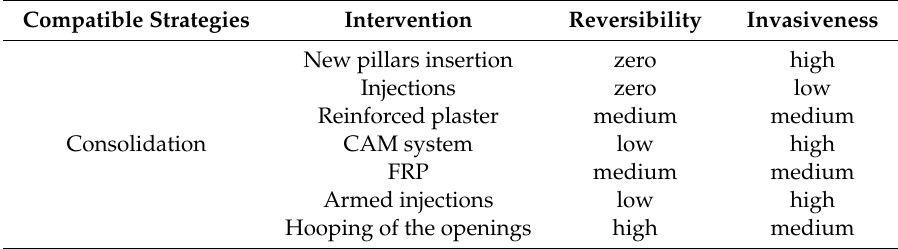
Table 3. Summary of the structural interventions studied for the stone